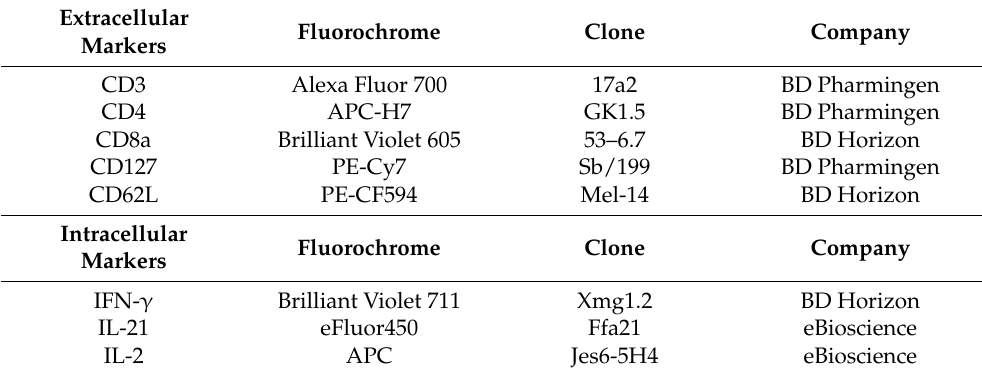
Table 1. Panel of anti-mouse antibodies used for the ICS assay.